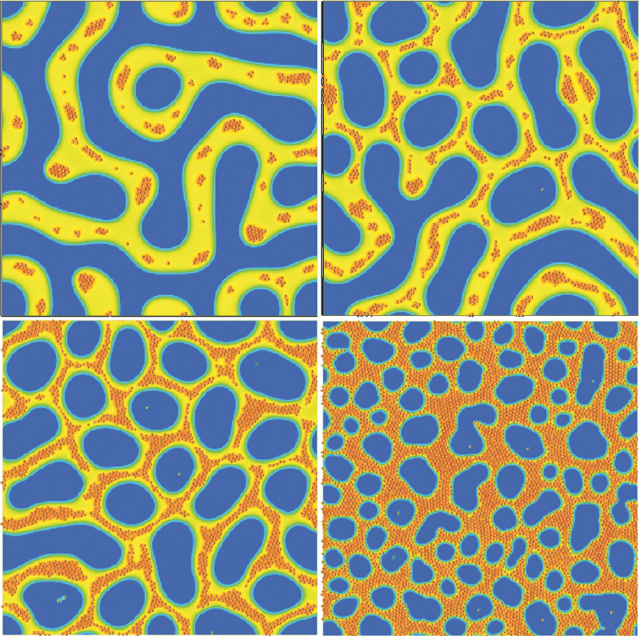
Figure 11. Phase transition for a lamellar BCP morphology and a concentration φ p = 0.05, 0.1, 0.2 and 0.5 of NPs, respectively, for top left, top right, bottom left and bottom right. Affinity of the NPs is ψ 0 = 1.2 > ψ eq , a larger value than the order parameter takes in the absence of colloids. Reprinted with permissions from Ref. [144], Copyright 2017 Wiley